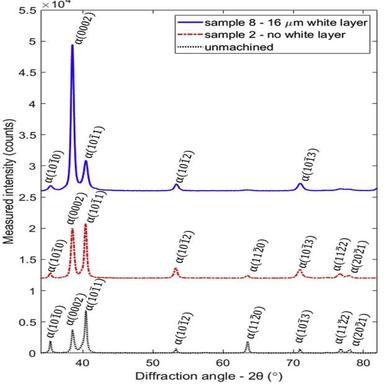
XRD patterns for a machined surface with a 20 μm white layer (top), a machined surface with no white layer (middle) and an unmachined surface for reference (bottom).